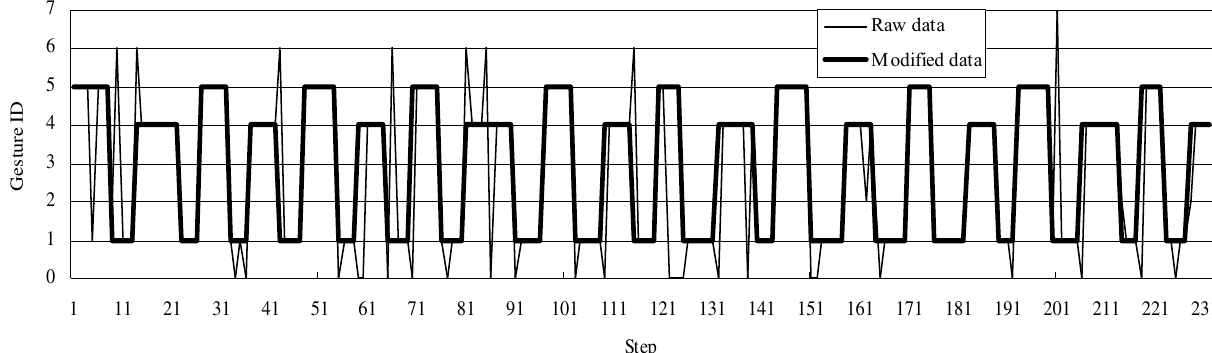
Figure 8 Raw recognition results and smoothing (for 514).